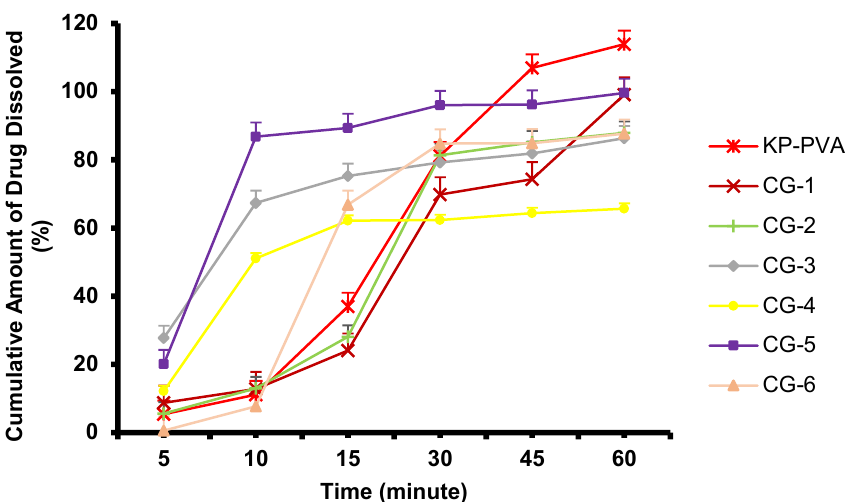
Figure 9. Dissolution profile curve of Co-grinded ketoprofen (n = 3, mean + SD, p > 0.05).